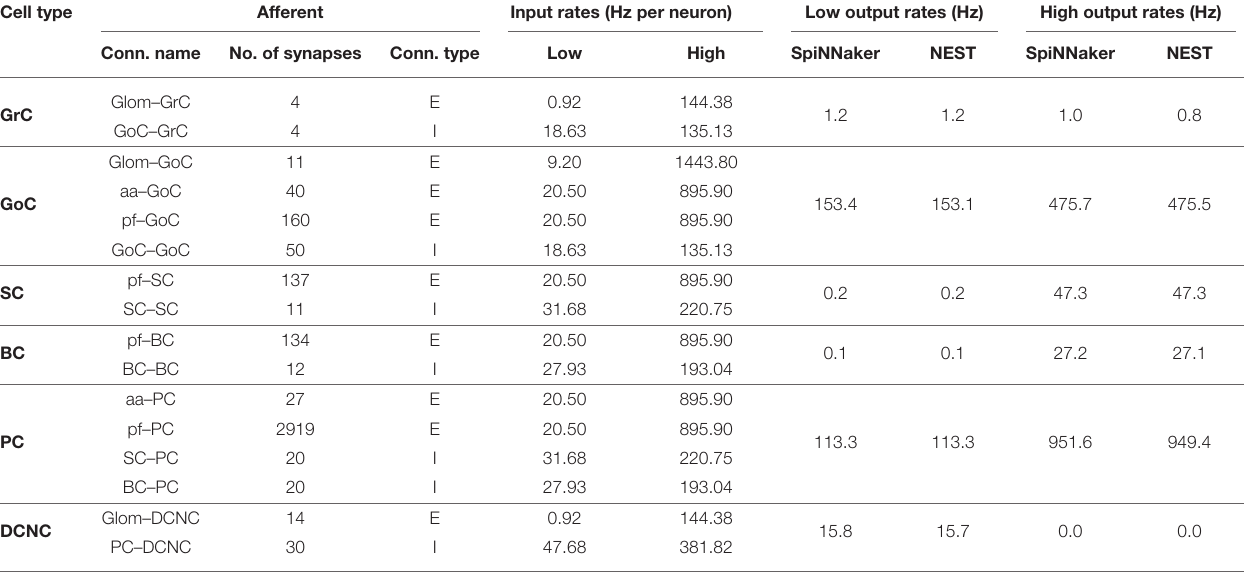
TABLE 4 | Single cell, realistic spikes, and connectivity test parameters and output firing rates.